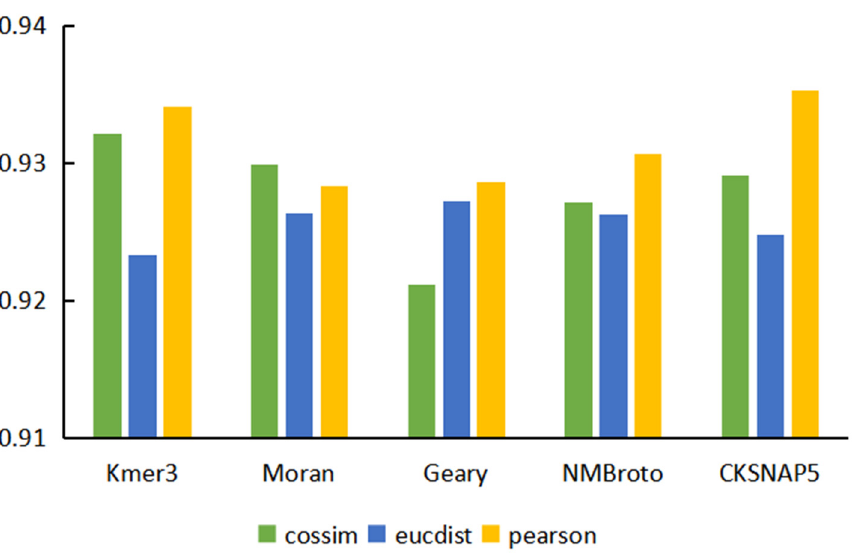
Figure 2. AUC of models based on different features and different similarity calculation